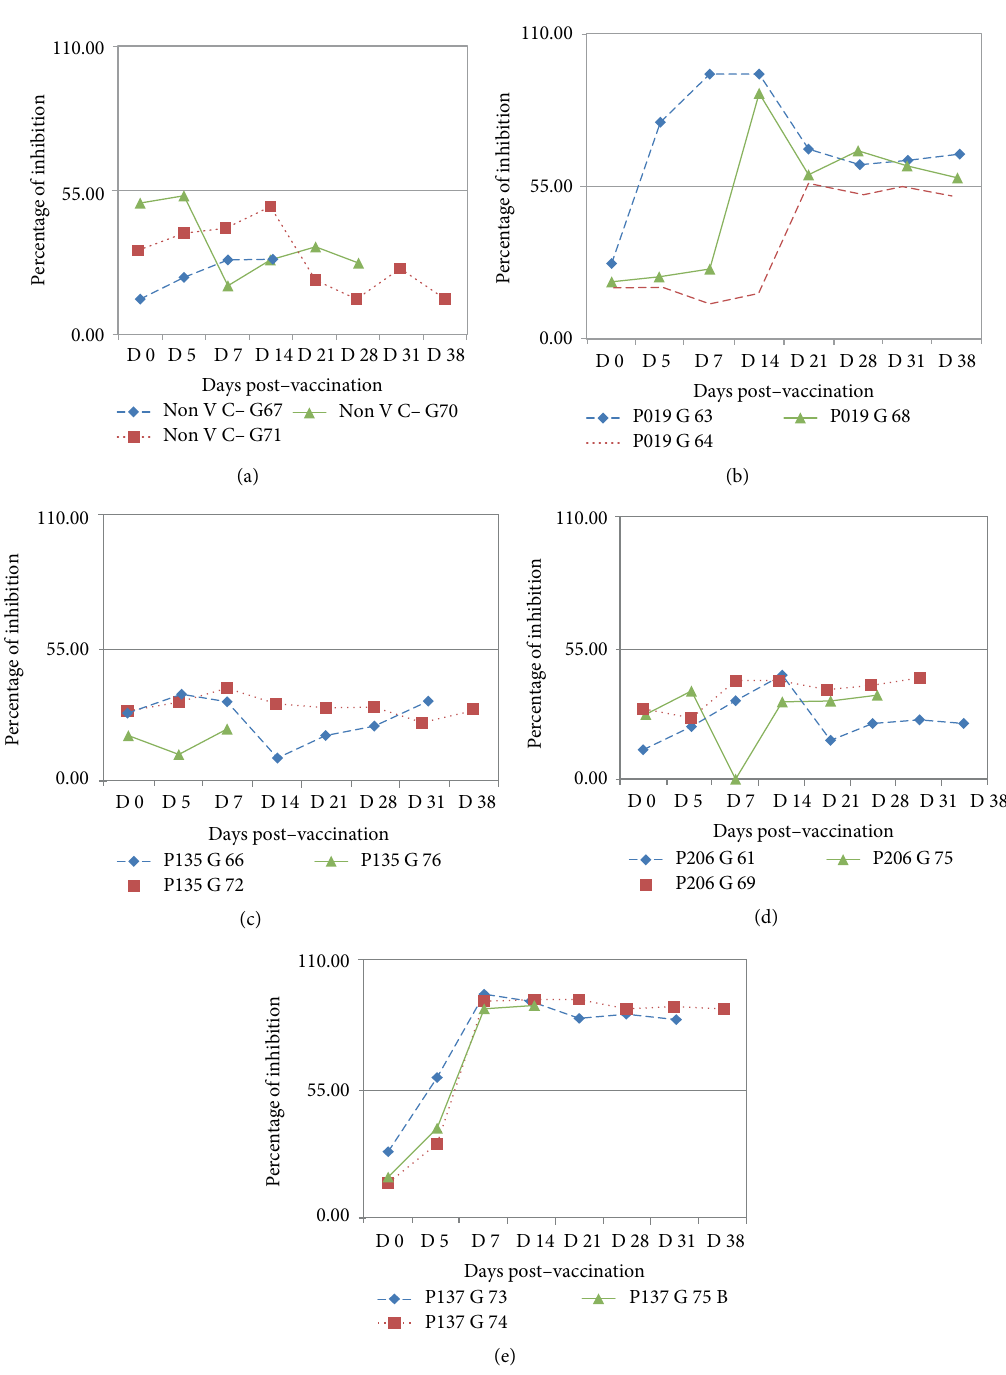
Figure 6: Kinetic of antibody development (expressed in percentage of inhibition) in vaccinated goats using P019, P137, P135, and P206 from Day 0 to D38 post-vaccination by CCPP c-ELISA. The cut-off of value for this test is 55% percentage of